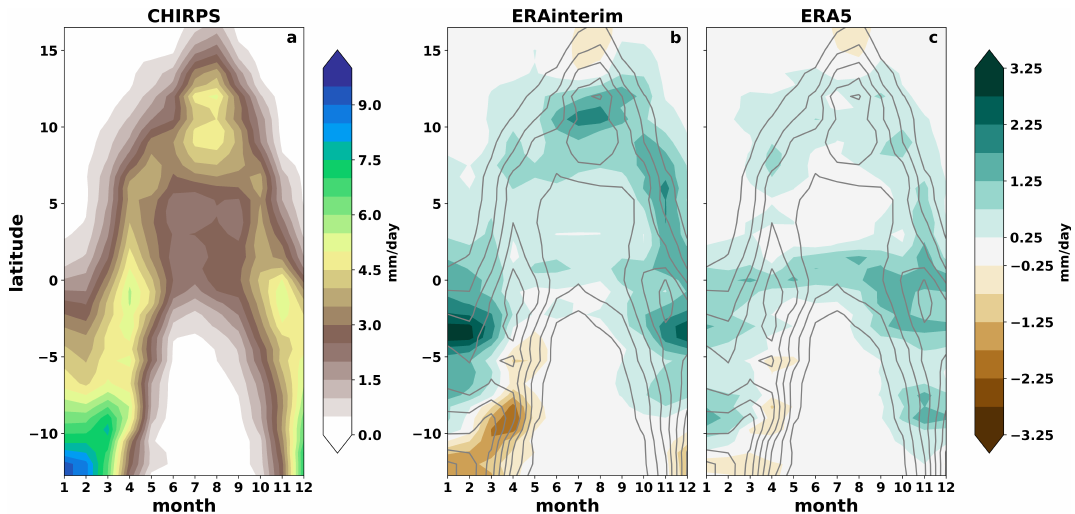
Figure 9. Monthly mean precipitation averaged over longitude band 25 ◦ E–50 ◦ E (East Africa box) and time period 1981–2017 from 13 ◦ S to 17 ◦ N in observations (CHIRPS, ( a )), and the difference between ERA-interim ( b )/ERA5 ( c ) and